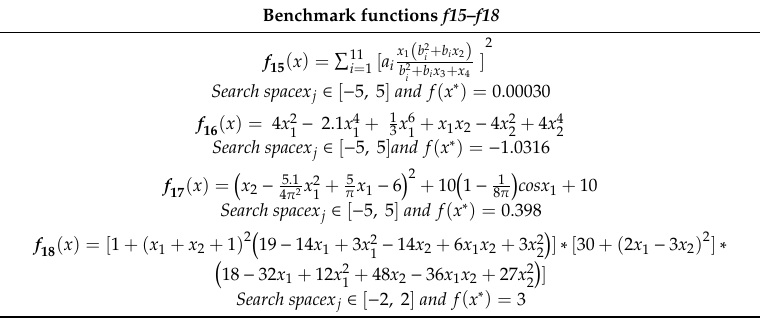
Table 4. Fixed-dimension multimodal benchmark functions.